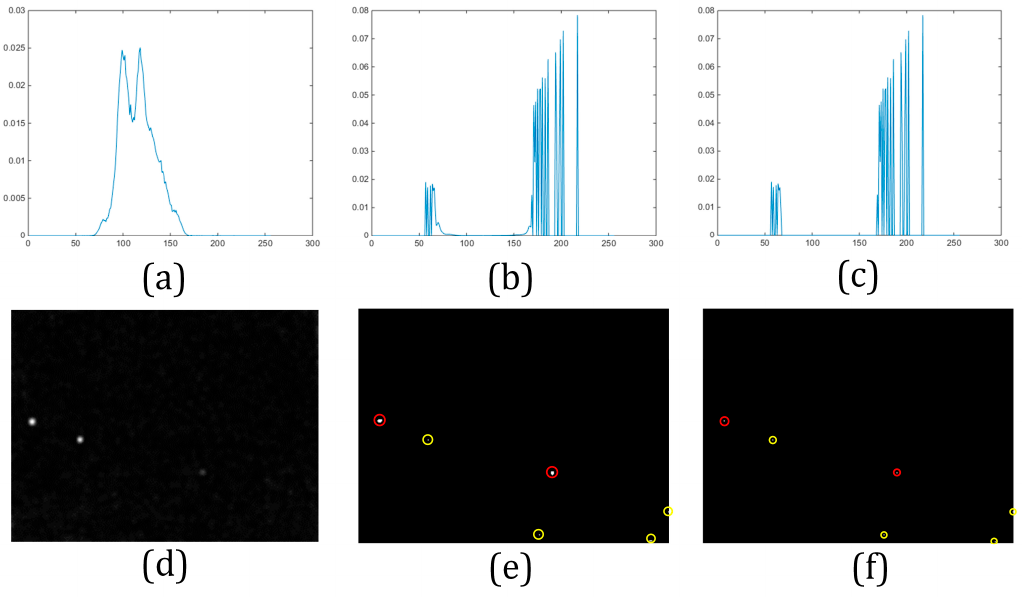
Figure 7. In-frame detection results of Seq.3 generated by our method: ( a ) intensity histogram; ( b ) original saliency histogram; ( c ) modified saliency histogram; ( d ) saliency map; ( e ) binarized image; ( f ) in-frame detection result.